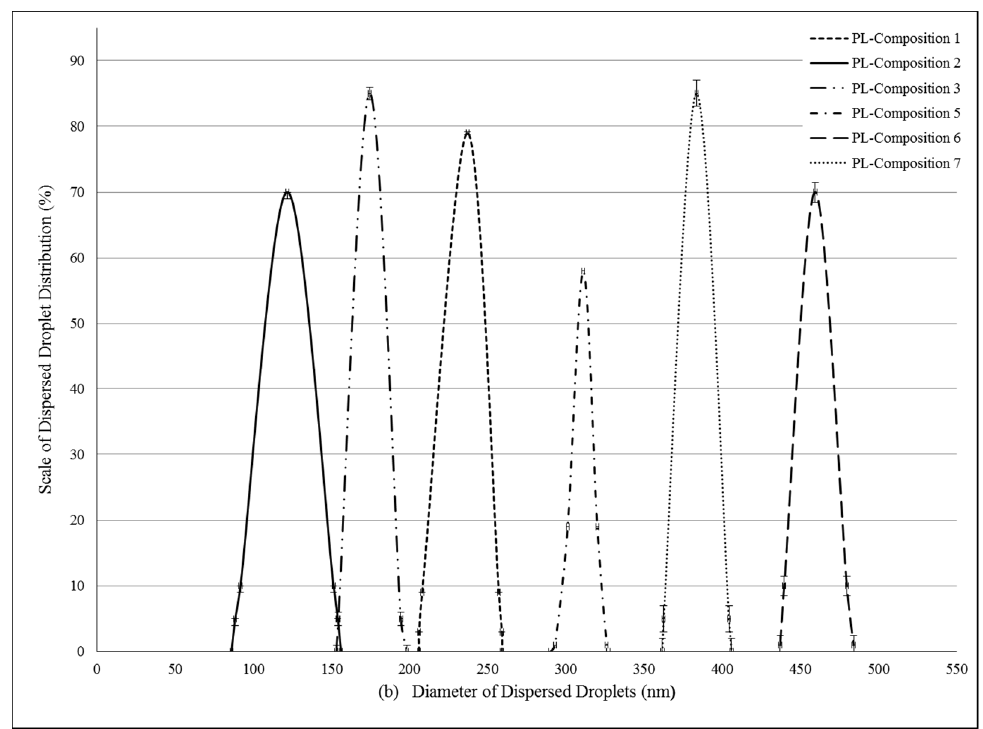
Figure 2. ( a ) Evaluated droplet size of self-nano-emulsifying drug delivery systems (SNEDDS) in water via dynamic light scattering (DLS) measurement. Evaluated average droplet sizes: composition 1 : 233.62 ± 2.34 nm, composition 2 : 141.51 ± 1.25 nm, composition 3 : 166.44 ± 1.05 nm, composition 5 : 374.89 ± 0.23 nm, composition 6 : 330.28 ± 0.95 nm, composition 7 : 251.81 ± 1.95 nm. Values are expressed as means ± SD, n = 5; ( b ) Evaluated droplet size of self-nano-emulsifying drug delivery systems (SNEDDS) in water via dynamic light scattering (DLS) measurement. Evaluated average droplet sizes: PL-composition 1 : 245.32 ± 0.64 nm, PL-composition 2 : 121.75 ± 1.00 nm, PL-composition 3 : 174.50 ± 1.00 nm, PL-composition 5 : 313.02 ± 3.12 nm, PL-composition 6 : 459.50 ± 3.85 nm, PL-composition 7 : 383.20 ± 2.55 nm. Values are expressed as means ± SD, n = 5.